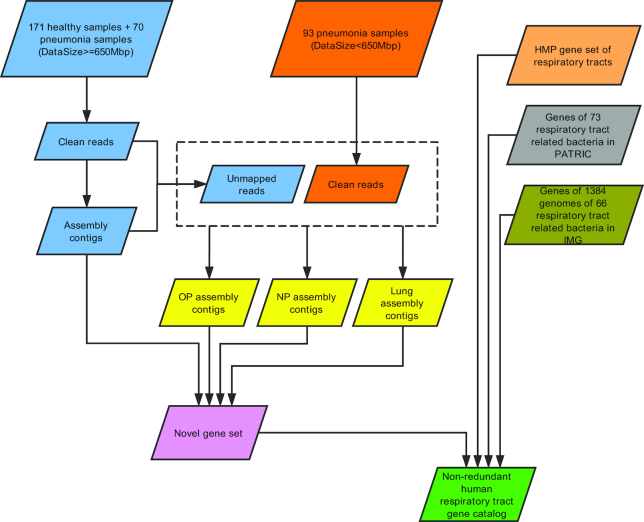
Construction of the human Respiratory Microbial Gene Catalogue (RMGC). Genome assembly was performed for each sample with ≥650 Mb of data. For samples with <650 Mb of data, data from the same respiratory site (NP, OP, or lung) were mixed and assembled. Gene predictions were conducted for all assembled contigs with ≥500 bp and respiratory bacterial genomes in the Integrated Microbial Genomes and Microbiomes (IMG) database. Genes with ≥100 bp were retained. Respiratory gene sets from the Human Microbiome Project (HMP) and Pathosystems Resource Integration Center (PATRIC) were combined to construct the non-redundant RMGC containing 2,245,343 genes.